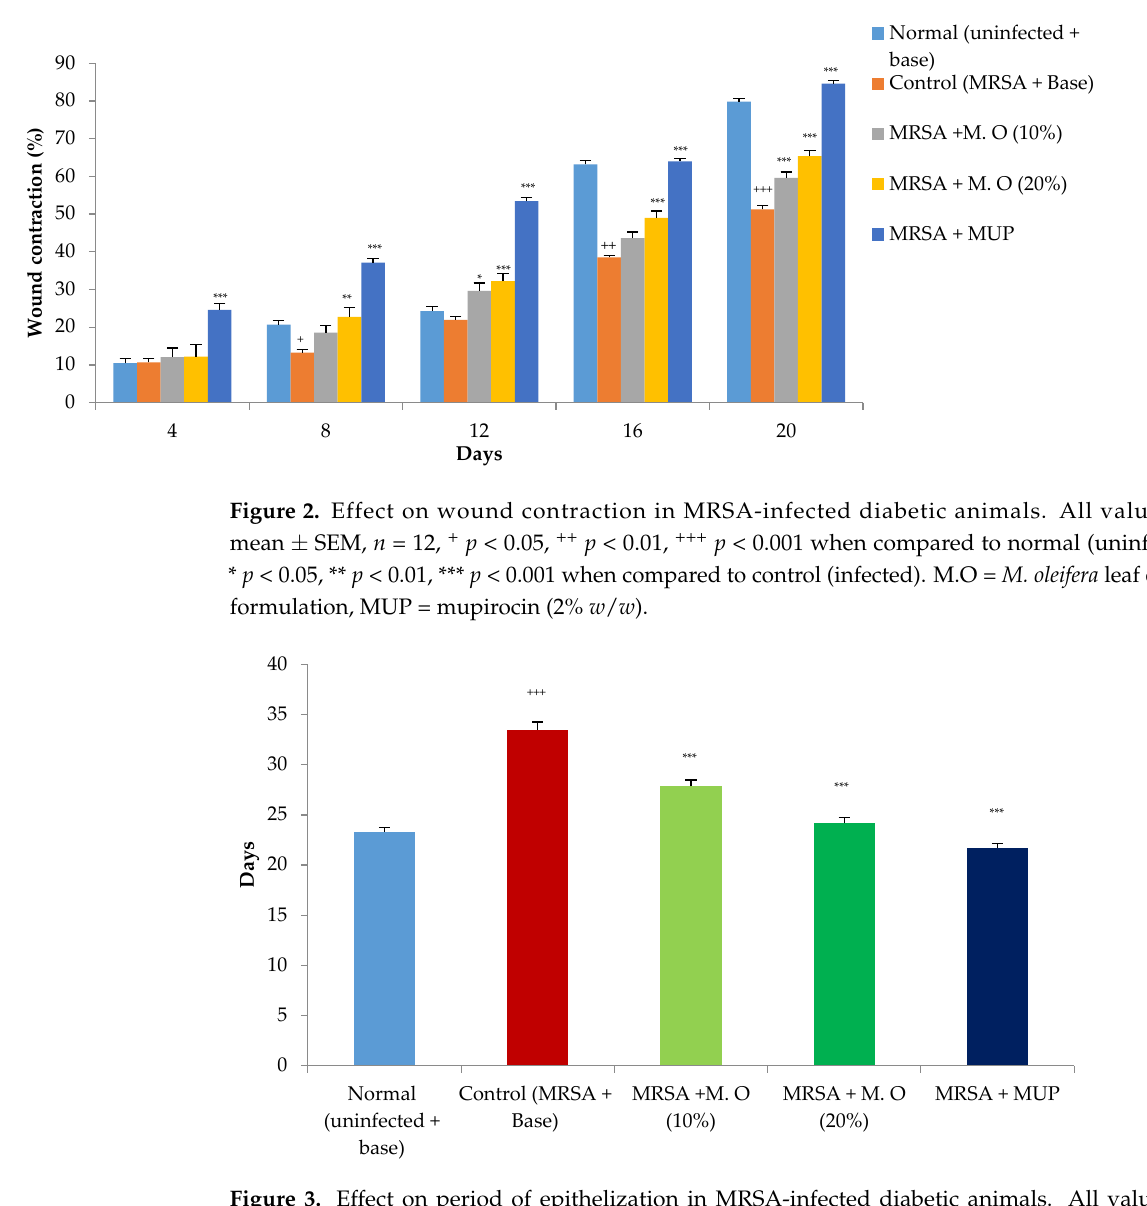
Figure 3. Effect on period of epithelization in MRSA-infected diabetic animals. All values are mean ± SEM, n = 6, +++ p < 0.001 when compared to normal (uninfected). *** p < 0.001 when compared to control (infected). M.O = M. oleifera leaf extract formulation, MUP = mupirocin (2% w / w ).